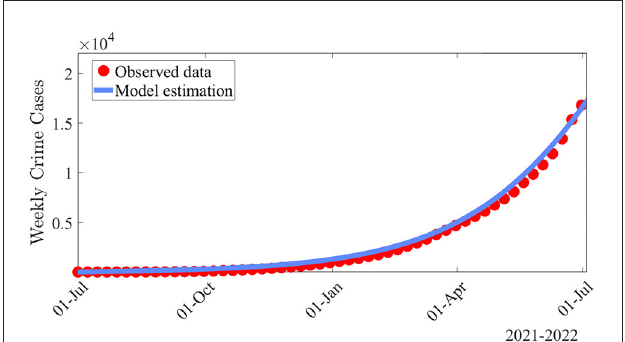
FIGURE2 Data fitting of the model (Equations 1–4) using weekly crime data for Illinois from 1 July 2021 to 30 June 2022. The simulations of the model (Equations 1–4) carried out using the parameters estimated from the weekly crime data for the Illinois. The values of the fixed and fitted parameters used for the purpose of the data fitting and parameter estimation are shown in Tables 3, 4, respectively.